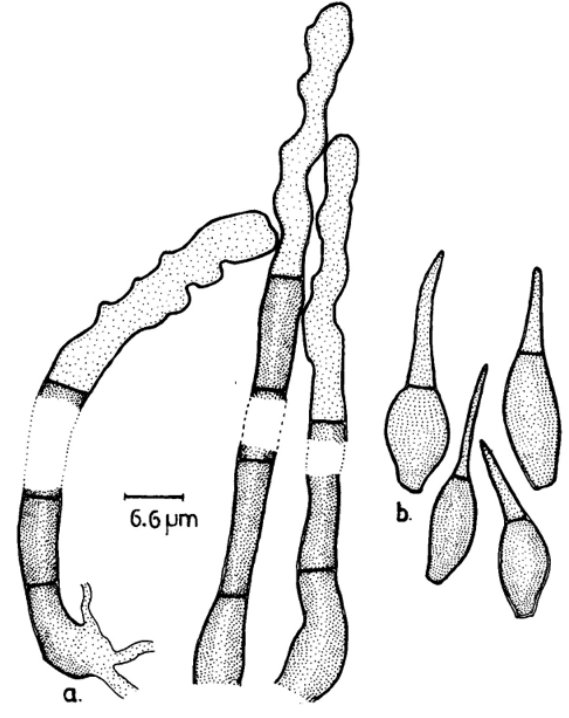
Figure 200. Spiropes armatellicola a - Conidiophore; b -